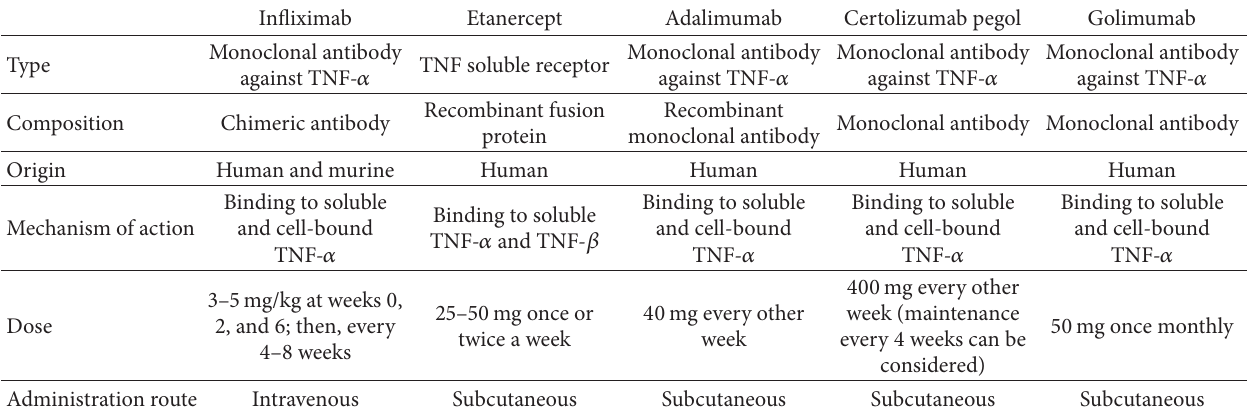
Table 1: Characteristics of the different anti-TNF